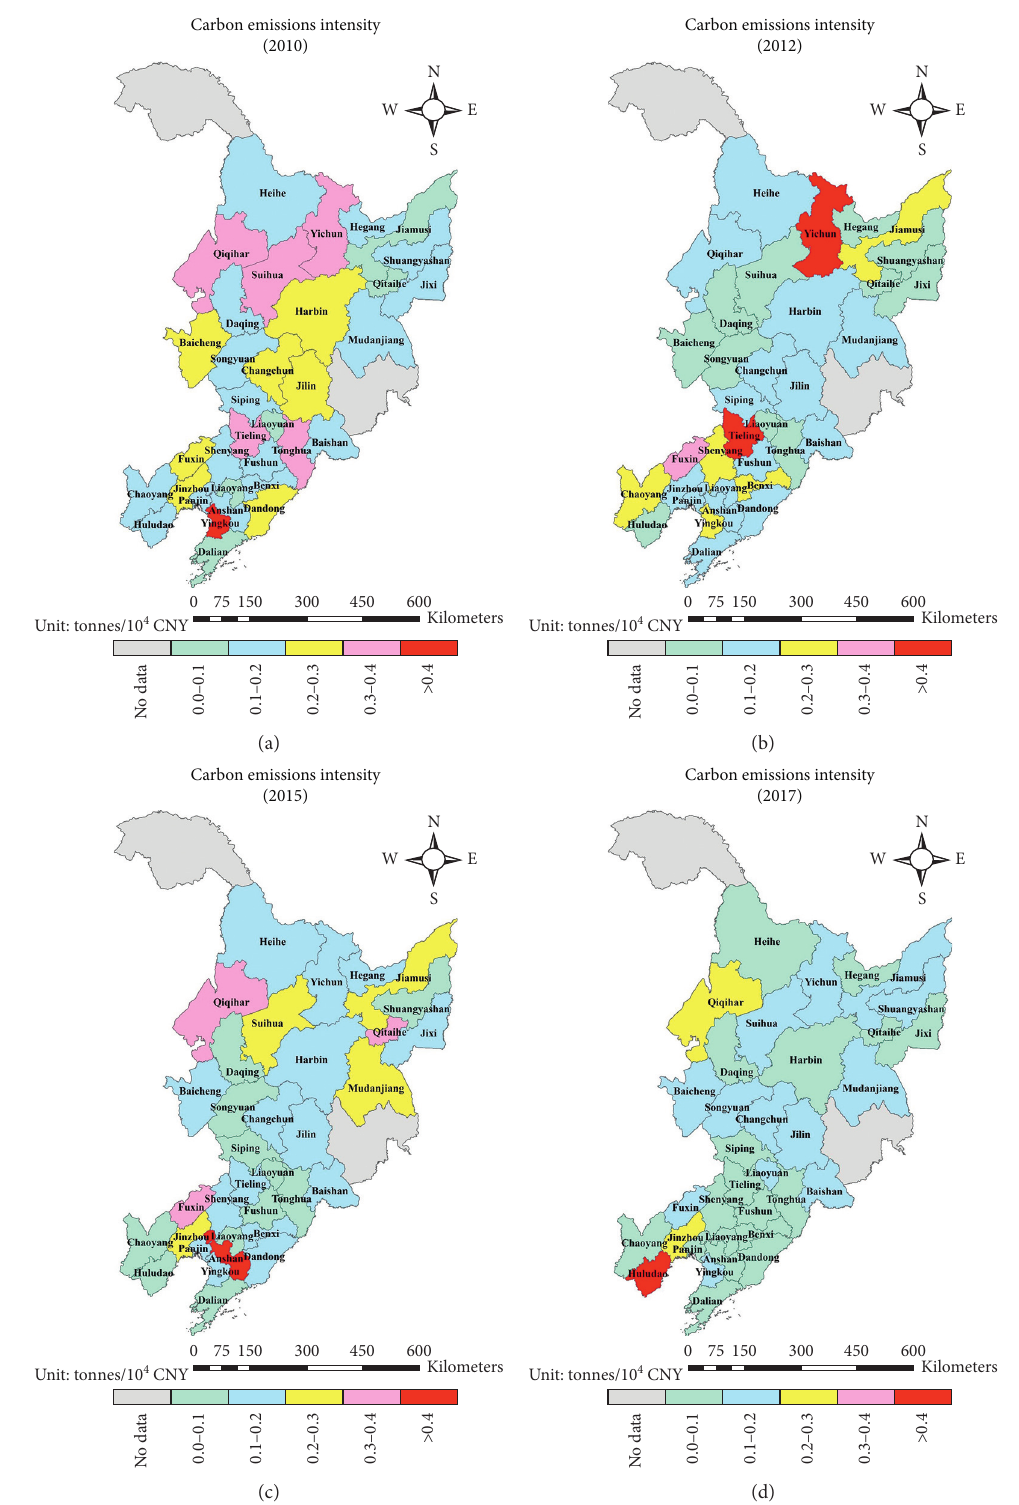
Figure 10: Spatial patterns of carbon emissions intensity (CEI) of infrastructure construction of 34 cities in Northeast China in 2010, 2012, 2015, and